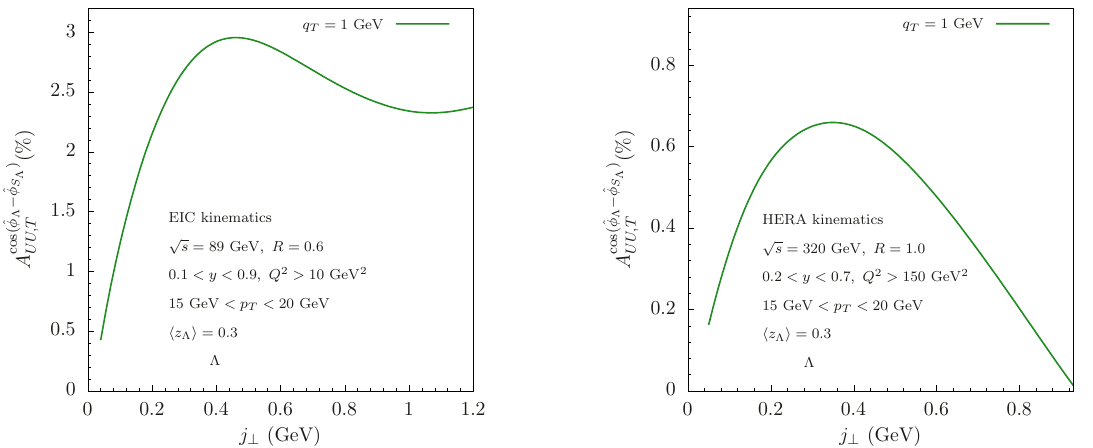
sin(ˆ φ ˆ φ S Λ ) Λ − in figure 9 as a function of transverse momentum j ⊥ UU,T